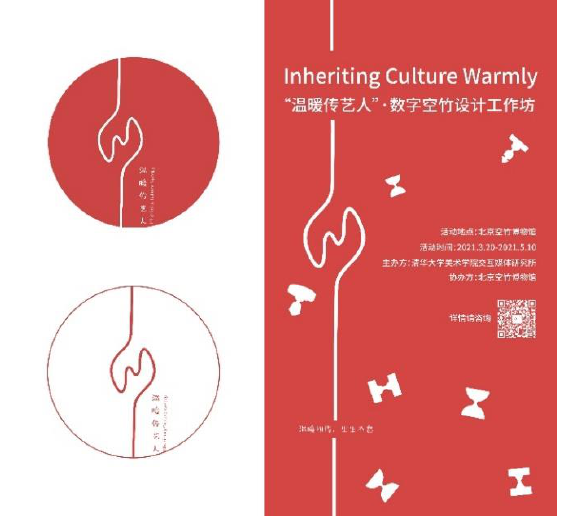
Figure 2. Visual System of "Warm Inheritors". Source: Authors